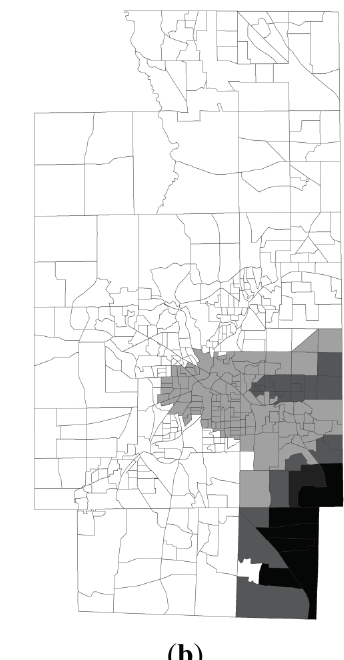
Figure 4. Spatial patterns of regression coefficients for educational attainment. ( a ) Census Tracts; ( b ) Census Block